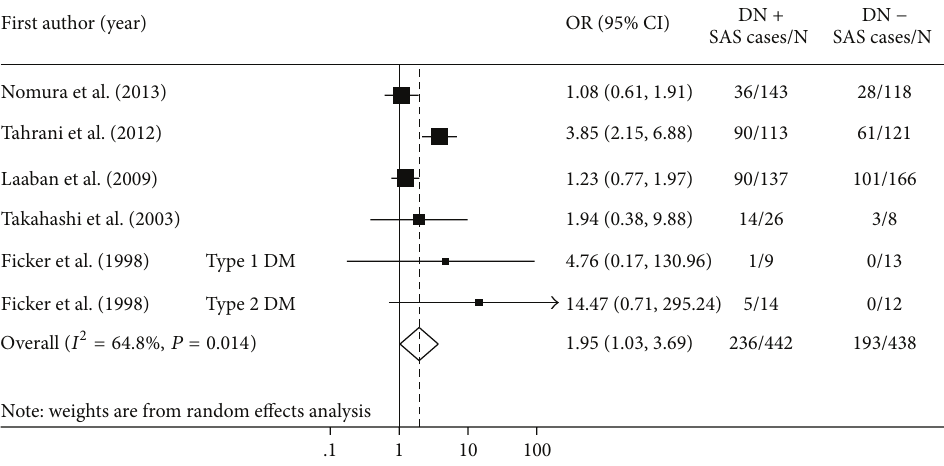
Figure 1: Forest plot showing the odds ratios (ORs) with 95% confidence interval (95% CI) of sleep apnea syndrome (SAS) for participants with diabetic neuropathy (DN) compared to participants without DN. Pooled OR is indicated by a diamond. The 95% CI of each OR is indicated by a vertical line. Size of squares reflects the statistical weight of each study.